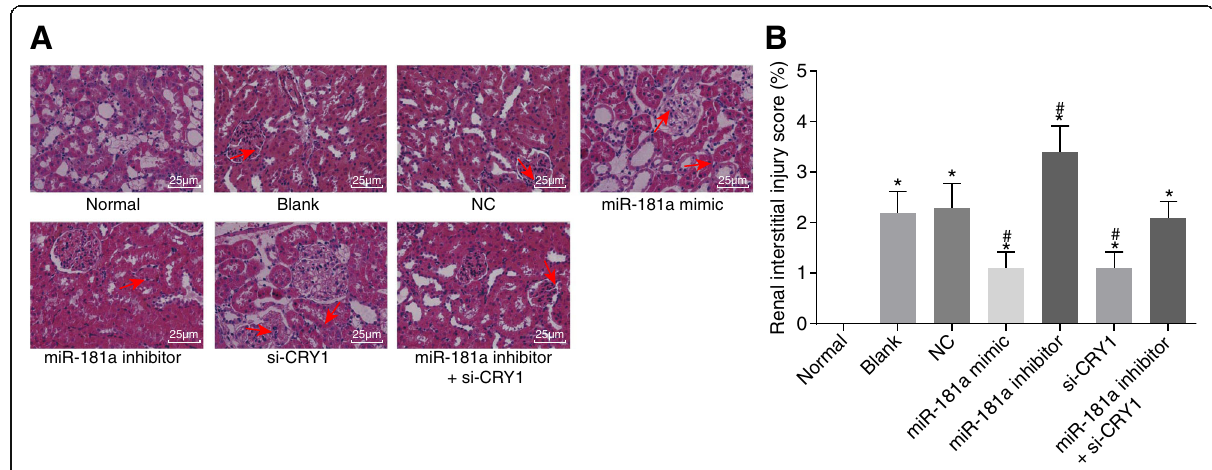
Fig. 4 HE staining of kidney tissues (× 400) reveals that the up-regulation of miR-181a or down-regulation of CRY1 reduces the degree of CKD. Notes: the arrows indicate glomeruli; a HE staining results in renal tissues (x 400); b renal interstitial lesion score. * , p < 0.05 vs. the normal group; # , p < 0.05 vs. the blank and NC groups; the data are presented as the mean ± standard deviation, analyzed by one-way ANOVA; the experiment was independently repeated three times; HE, hematoxylin-eosin; NC, negative control; miR-181a, microRNA-181a; CRY1, cryptochrome 1